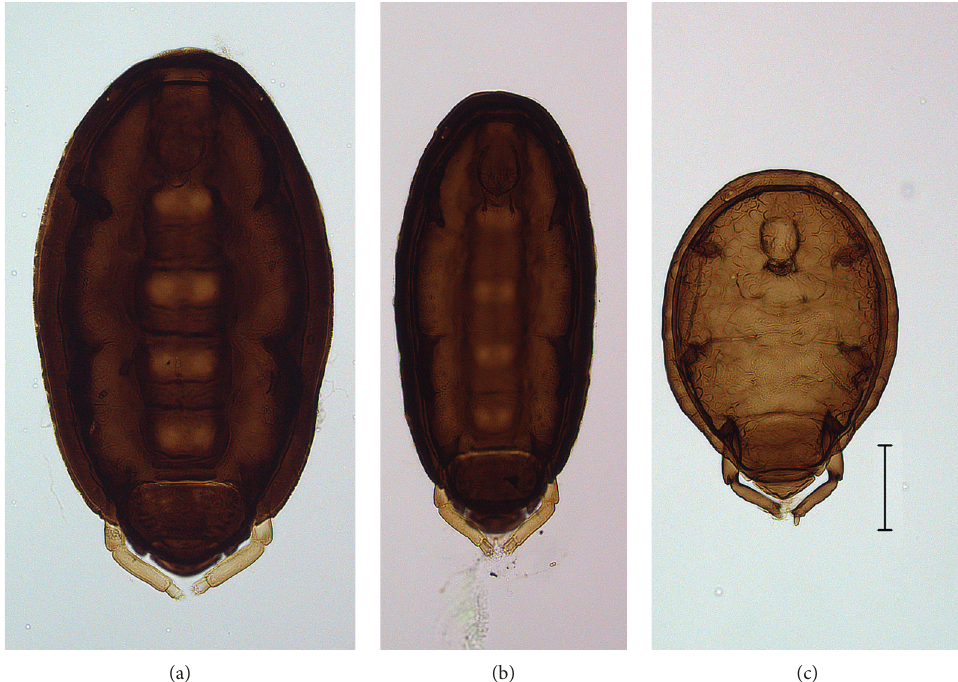
Figure 3: Apterous adults of Neothoracaphis : (a) a large individual of N. elongata (collected from Quercus acuta in Tanegashima Island, Kagoshima Prefecture, Japan, on 5 November 2017); (b) a small individual of N. elongata (collected from Q. acuta in Shiba, Tokyo, Japan, on 8 December 2018); (c) N. yanonis (collected from Q. serrata in Tama, Tokyo, Japan, on 9 October 2013). Scale bar: 100 μ